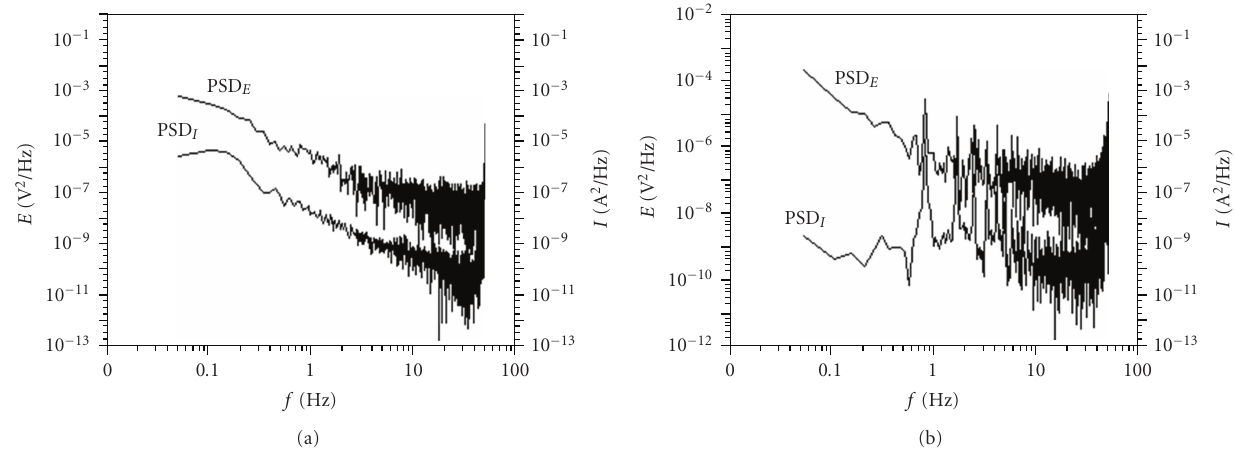
Figure 4: Current and potential noise power spectral density (PSD) plot, (a) copper in 0.5-MHCl, (b) copper in 0.5-MHCl with 10mM of